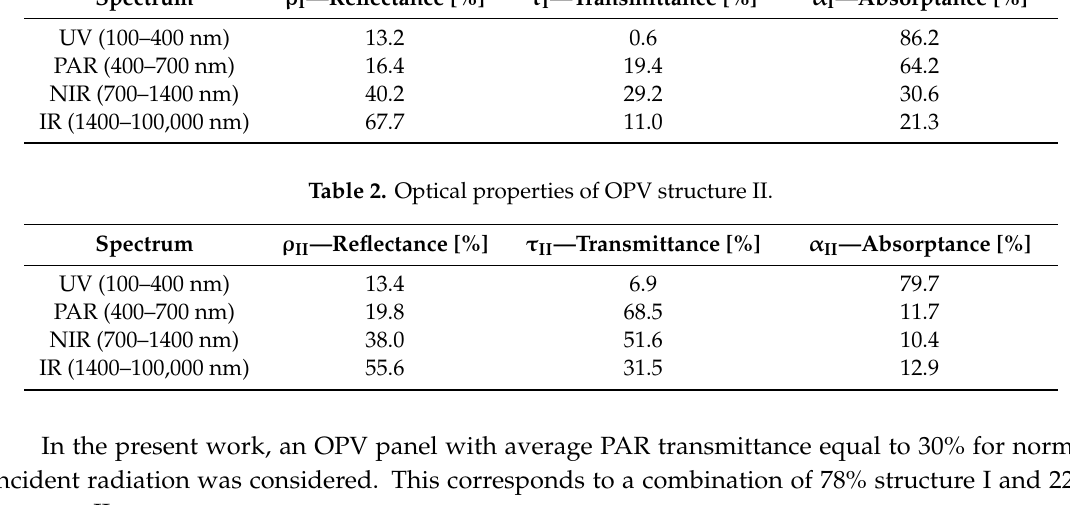
Table 1. Optical properties of OPV structure Ι .